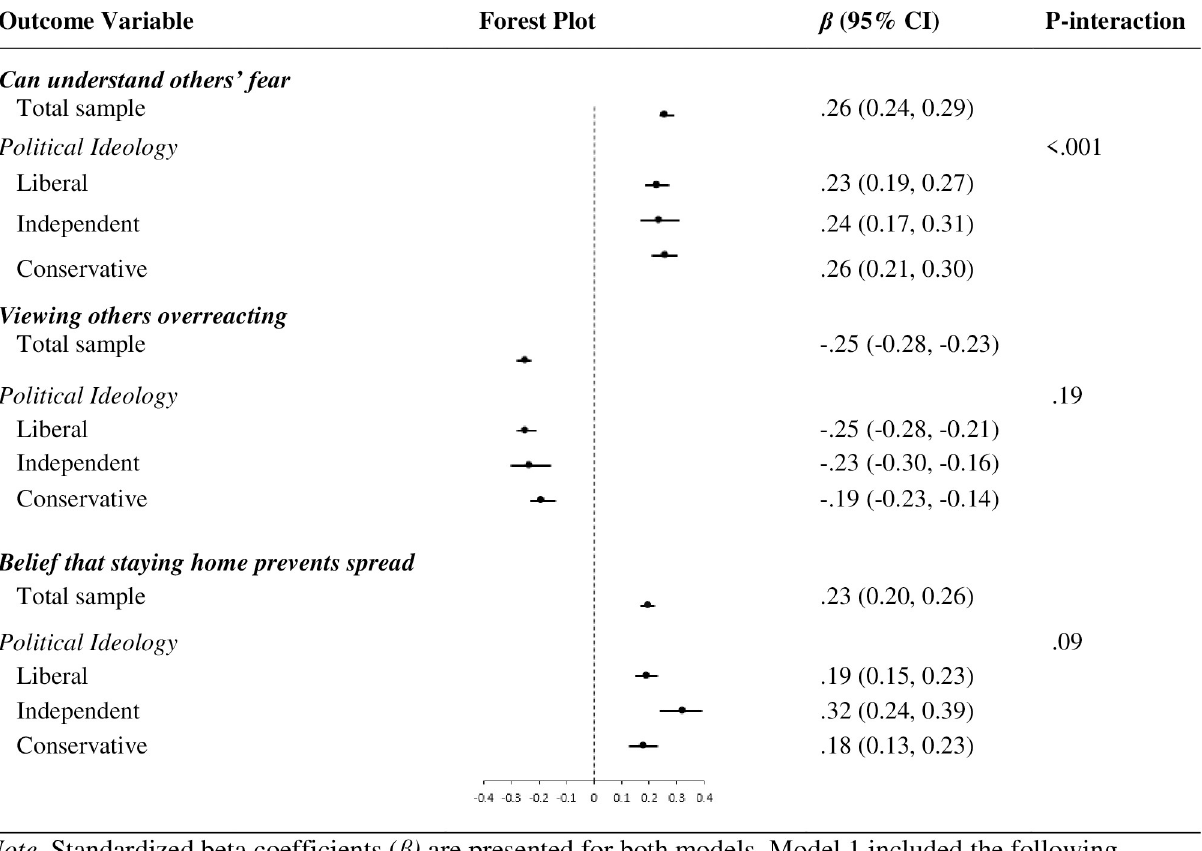
Fig 2. Depicts the forest plots for the associations (standardized beta coefficients) between empathy and three prosocial attitudes: Can understand others’ fear, viewing others as overreacting, and belief that staying home prevents the spread of COVID-19. The first forest plot for each attitude outcome is for the total sample, and the following three forest plots are for the sub-groups of liberal-leaning, independent, and conservative-leaning participants. The figure also depicts the 95% confidence intervals and the p-value for the interaction term between empathy and political ideology.